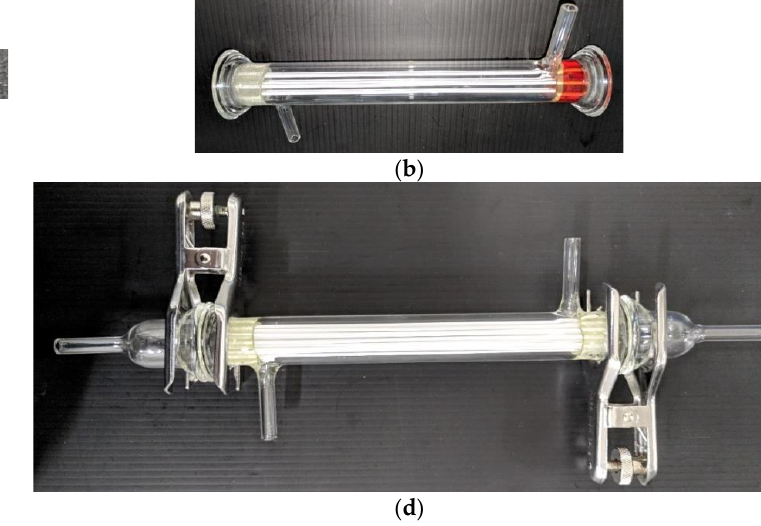
Figure 6. Details of the configuration of the hollow fiber membrane module. ( a ) Fiber cell; ( b ) A bunch of fiber cells in a circular tube; ( c ) Wrapped cap; ( d ) Circular hollow-fiber module.